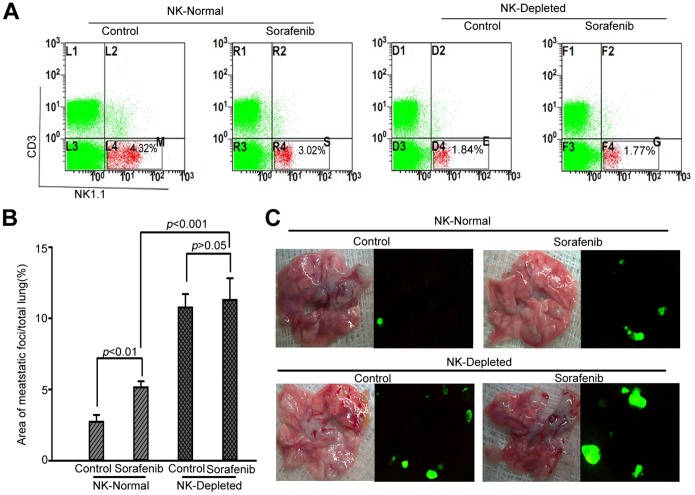
Sorafenib pretreatment promoted lung metastasis only in mice with intact NK cells.(A) At day 7, the ratio of NK cells in the spleens was determined by flow cytometry. (B) The metastatic index was measured by the ratio of the area of GFP-positive lung metastatic foci to total lung area. There was no significant difference between vehicle and sorafenib in NK cell–depleted groups (n = 5 for each group).